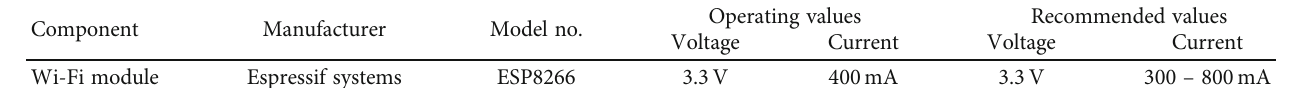
Table 3: Speci fi cations of Wi-Fi module.